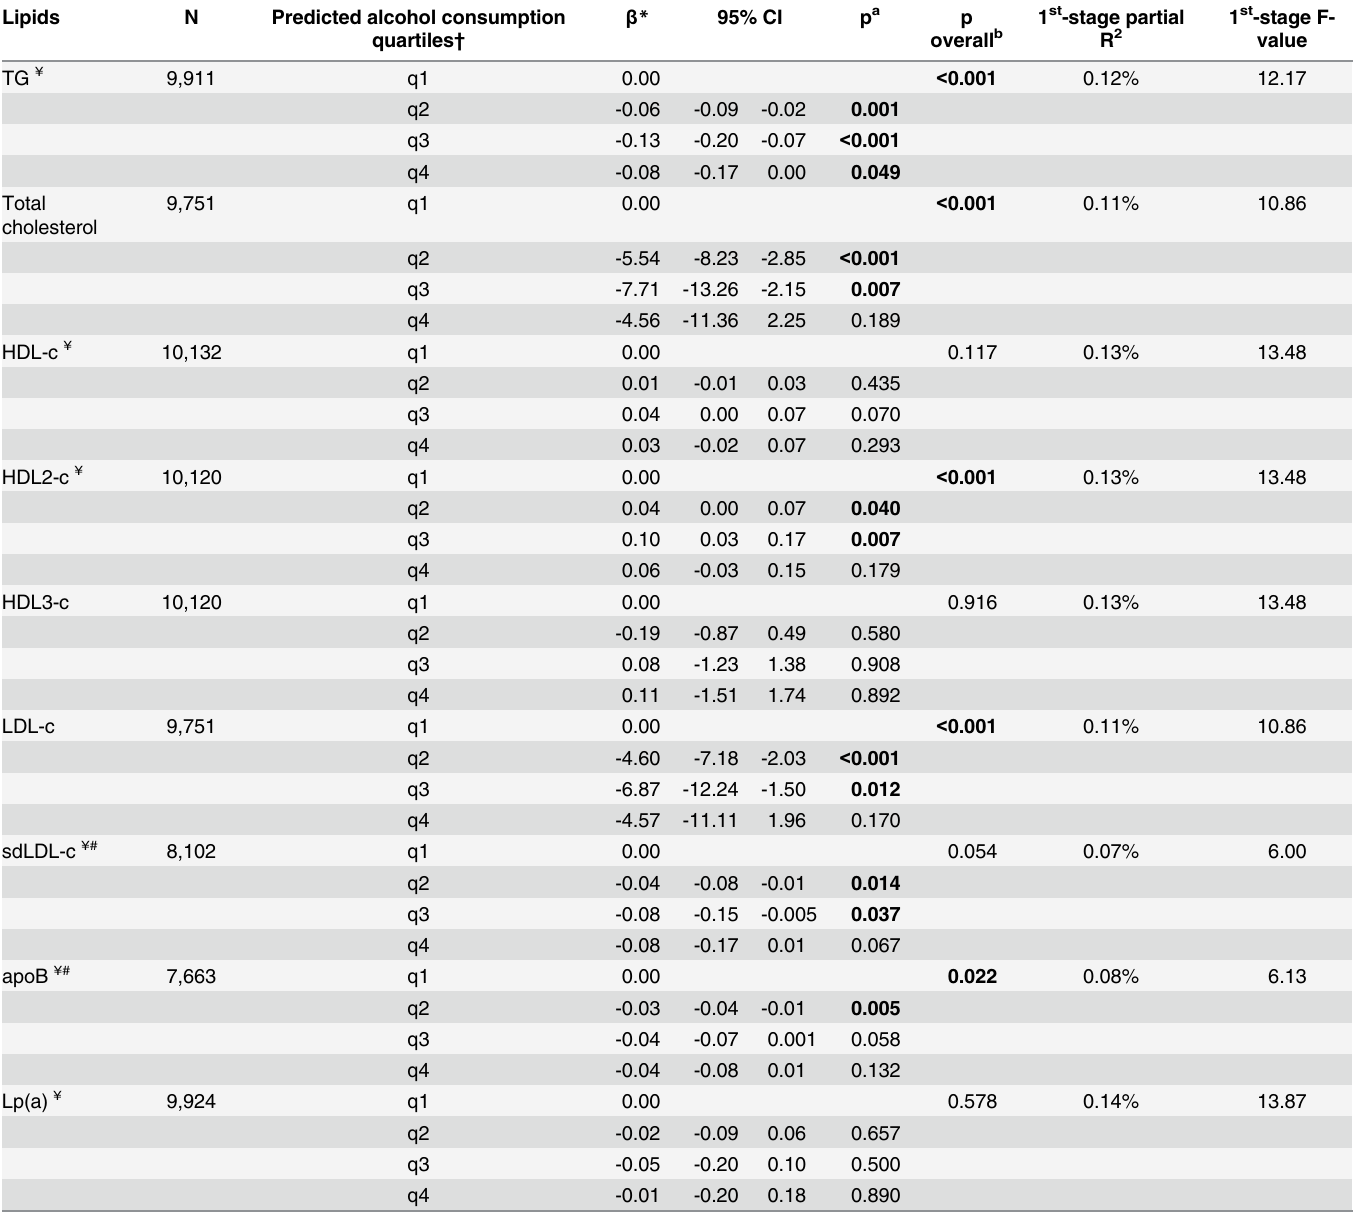
Table 4. Instrumental Variable analysis using 2SLS.